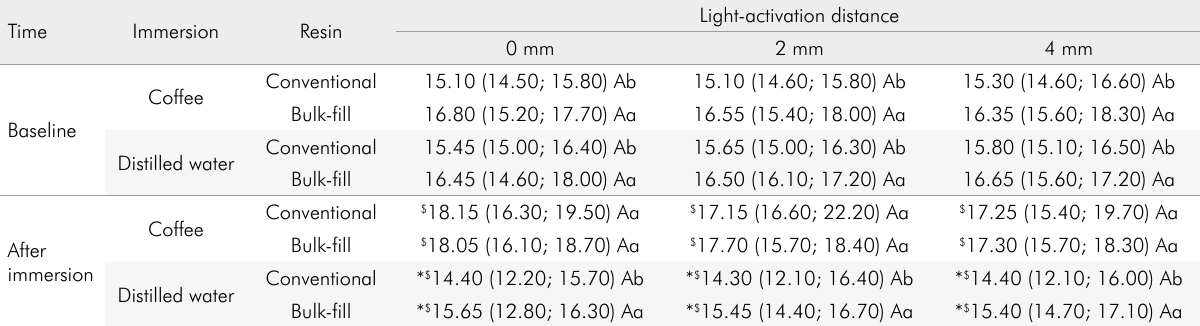
Table 4. Median (minimum value; maximum value) of b* value as a function of composite resin, immersion medium, light-activation distance and moment of